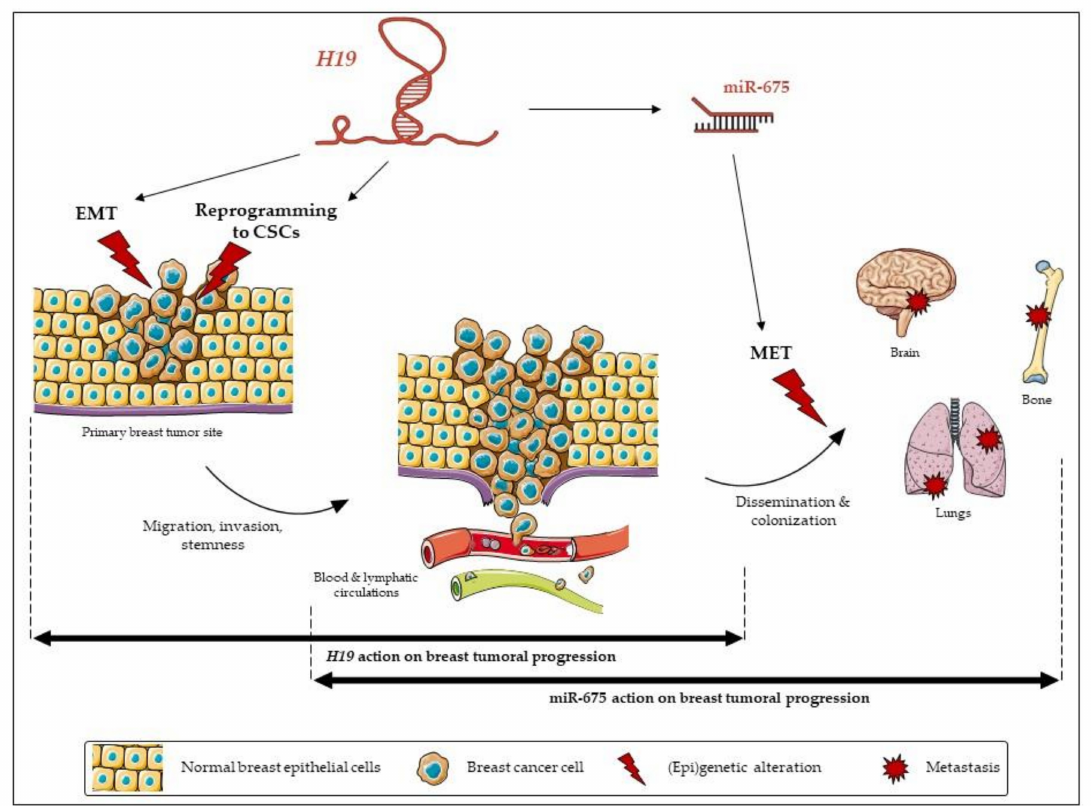
Figure 8. The relative contribution of long non-coding (lnc)RNA H19 and its miR-675 in breast cancer